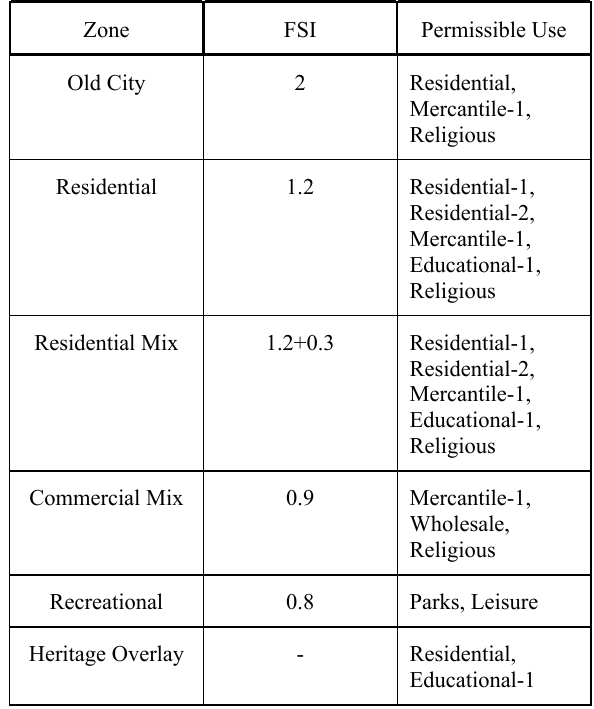
Table 2. Development Control Regulation